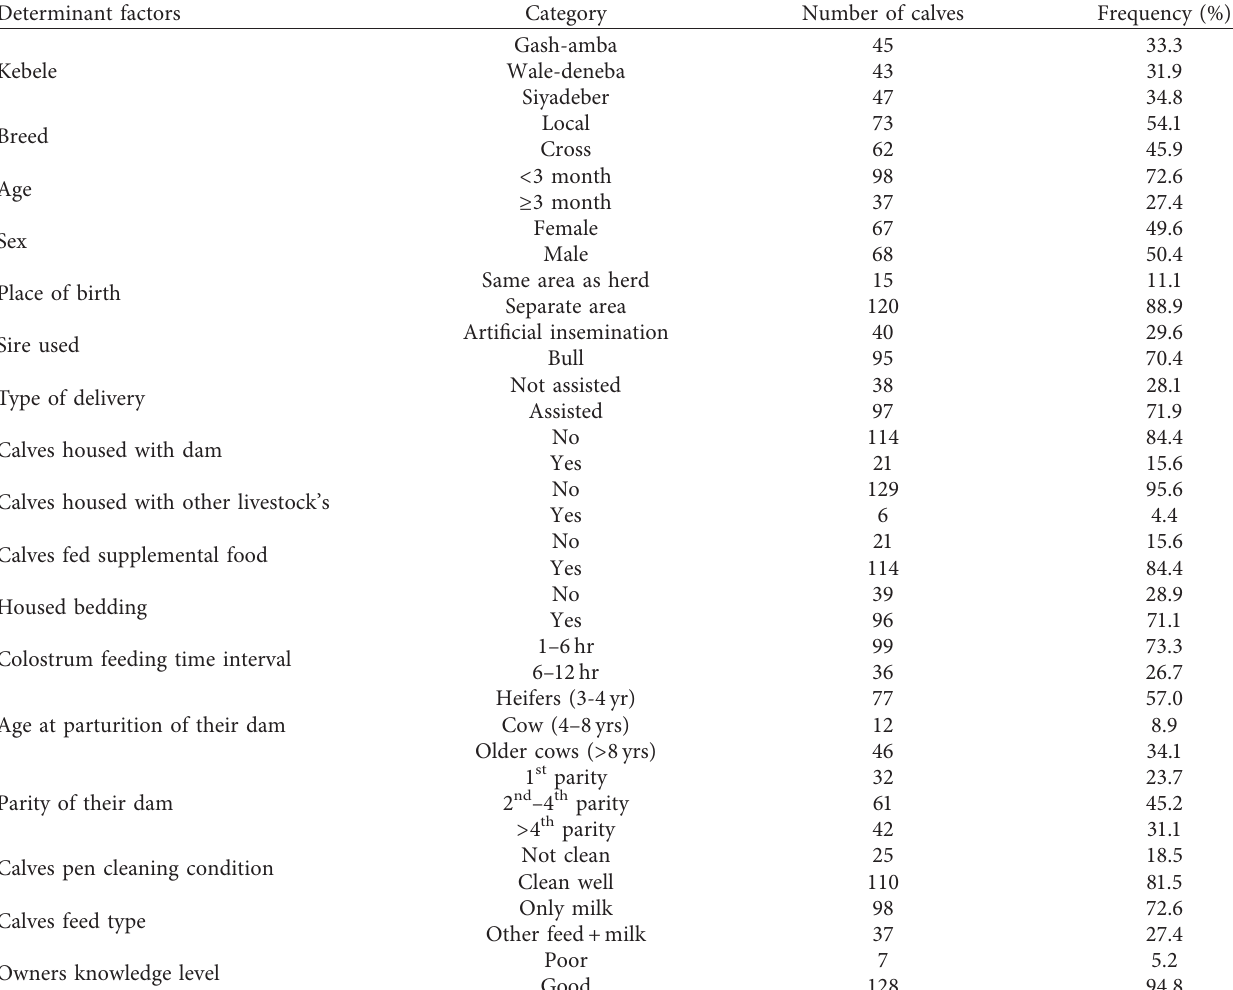
Table 2: Frequency distribution of the calves among the study variables at Siyadeber and Wayu District, North Shewa, Amhara region, Ethiopia ( n � 135).